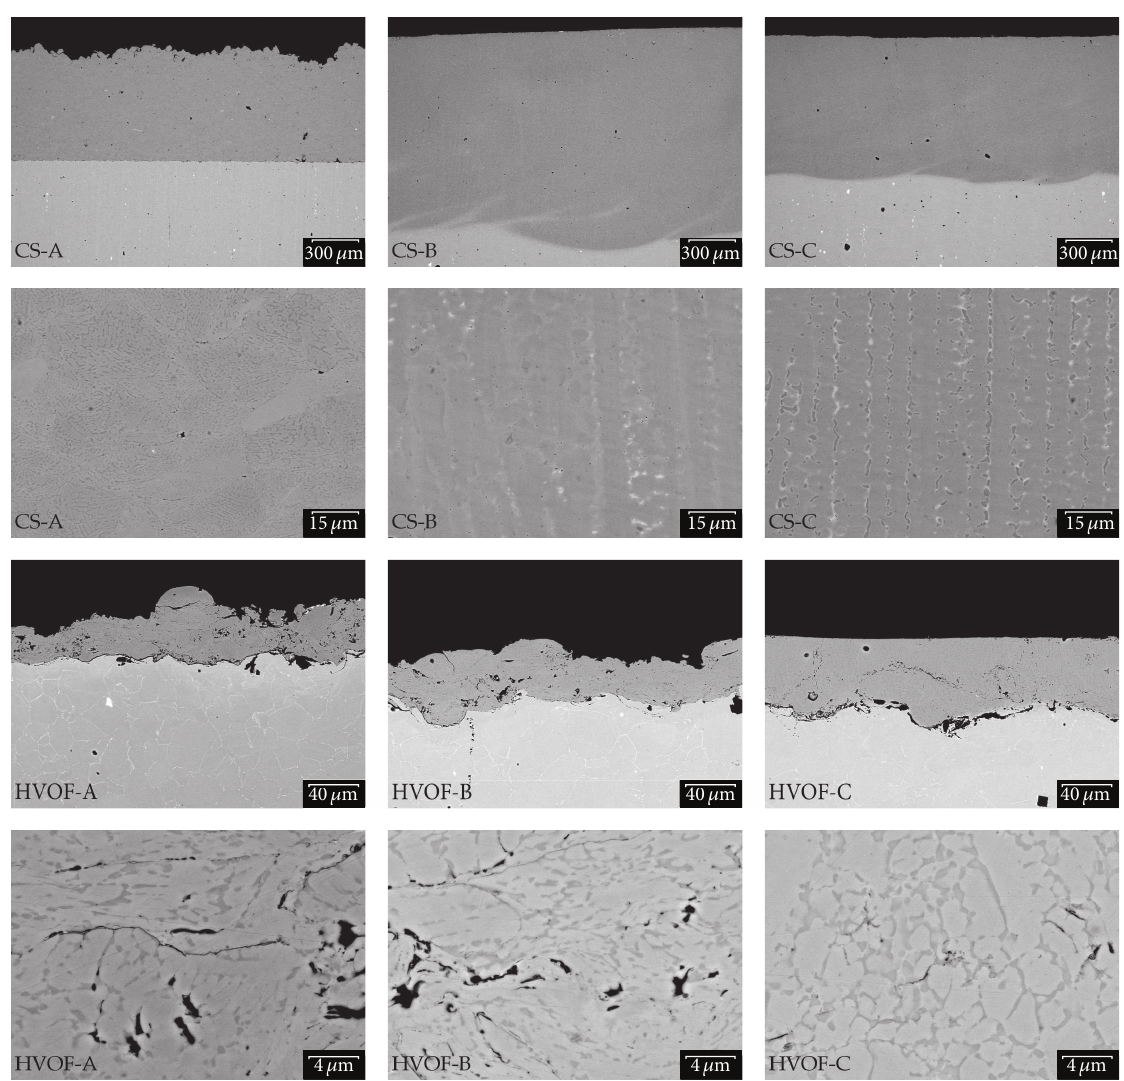
Figure 3: Interface and surface features and detailed microstructure of as-sprayed and EB modified